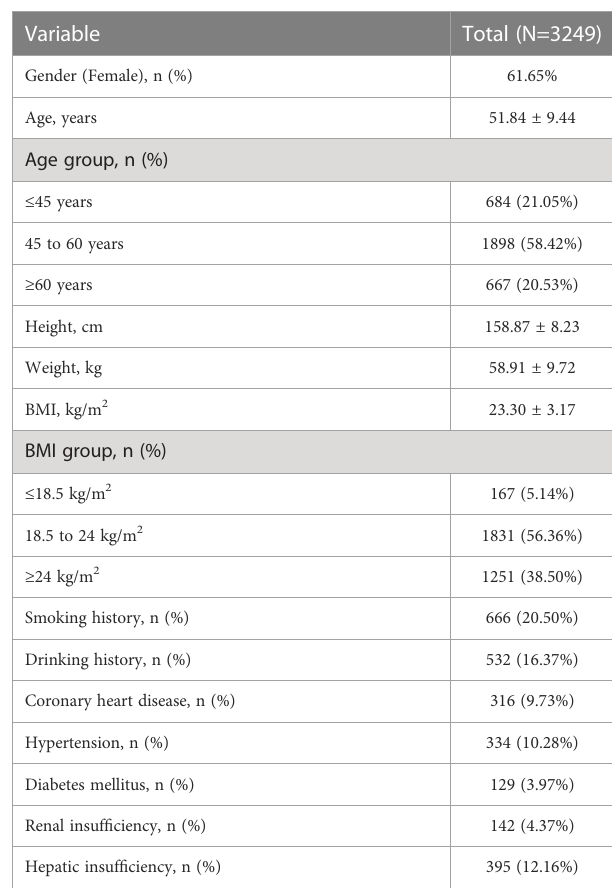
TABLE 1 Demographic and clinical data.